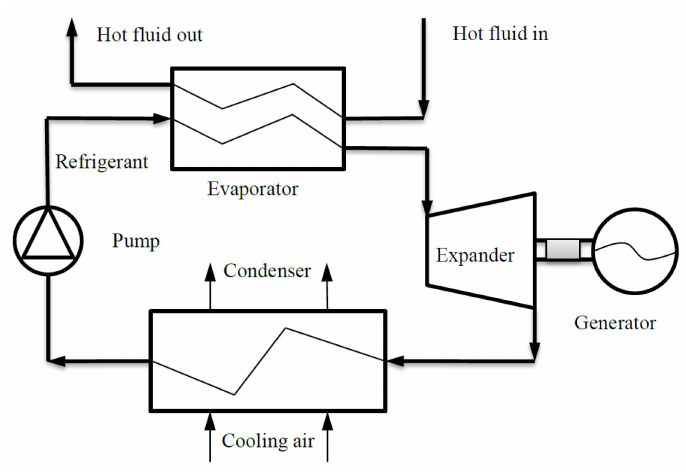
Figure 1. Components of a typical Organic Rankine Cycle (ORC) WHR